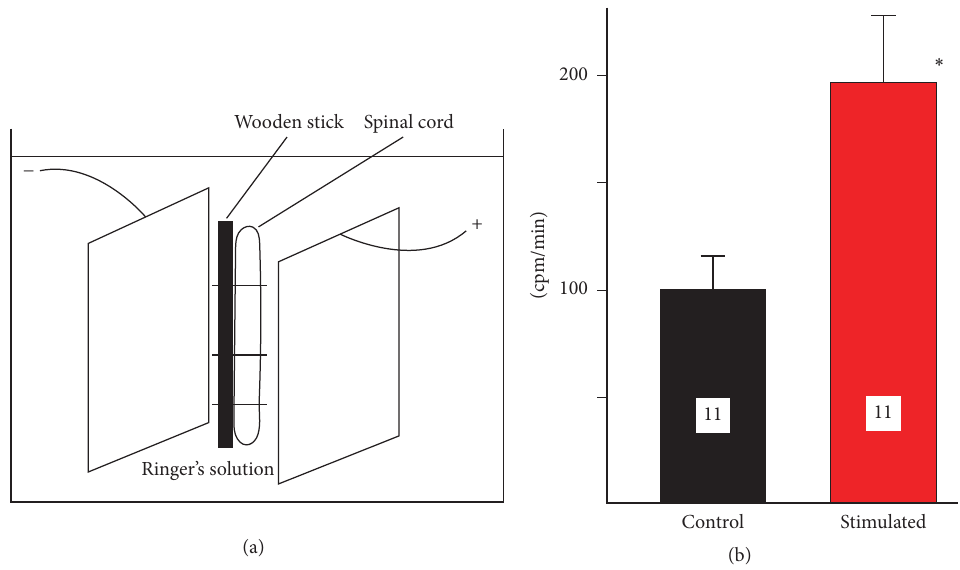
Figure 3: The 45 Ca 2+ accumulation by the segments of the spinal cord stimulated in vitro by two electrodes of the same size. (a) An experimental setup. Two stainless steel plates (30 × 7 mm) were placed 9 mm apart inside of the plastic tube and connected to the source of DC. The segment of the spinal cord, attached to the wooden stick, was placed between two electrodes. (b) Accumulation of 45 Ca 2+ in the segment of the spinal cord (in cpm/mm) following 3 mA, 3 󸀠 stimulation. The increase in stimulated spinal cord (190.9%) is statistically significant ( ∗ 𝑝 < 0.029 , 𝑡